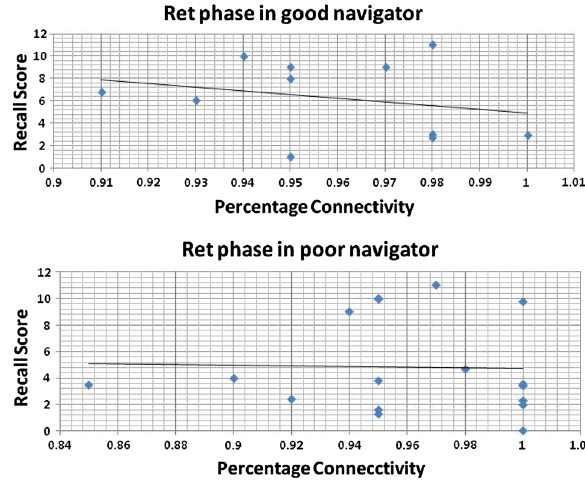
Fig. 6 Scatter plot between recall score and total percentage connectivity during Retrieval phase in good navigator ( R 2 = 2%), and poor navigator ( R 2 =